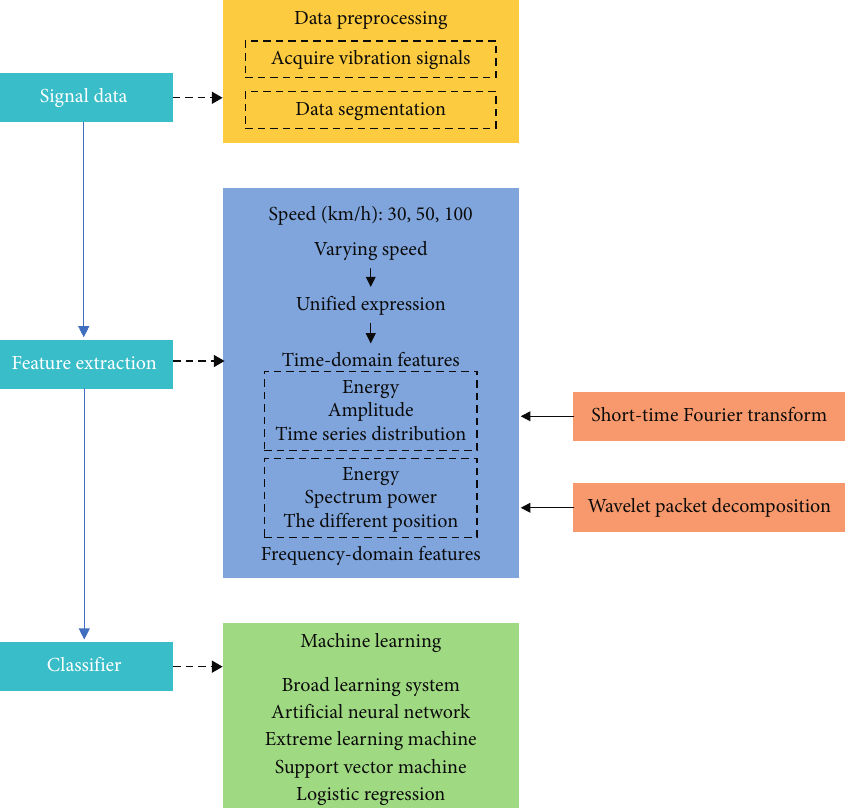
Figure 1: The framework of the proposed